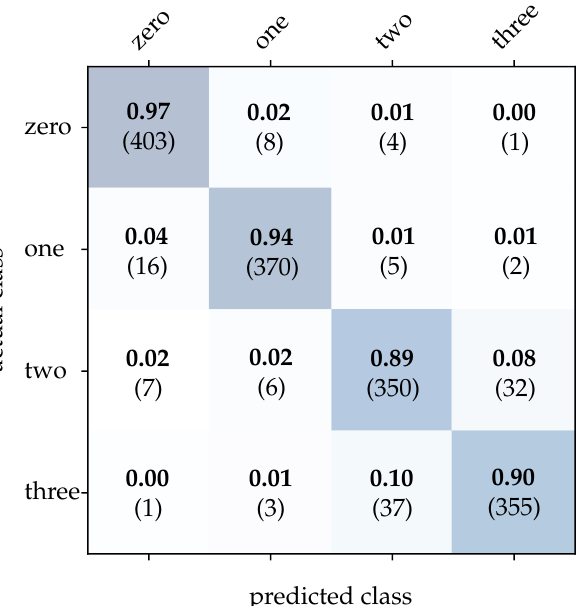
Figure 11. Classification results using image reconstruction and the wooden balls dataset. The bold values denote the relative frequency, the number in brackets the absolute number of samples.